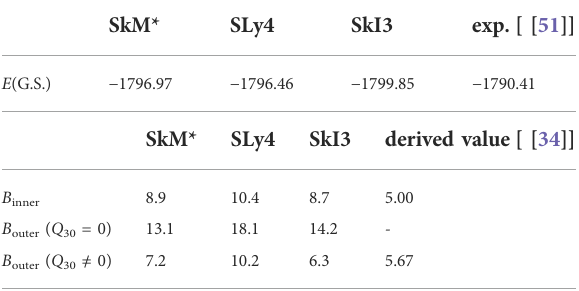
dE dE t0 , open triangles t1, t2 , solid triangles dE pair